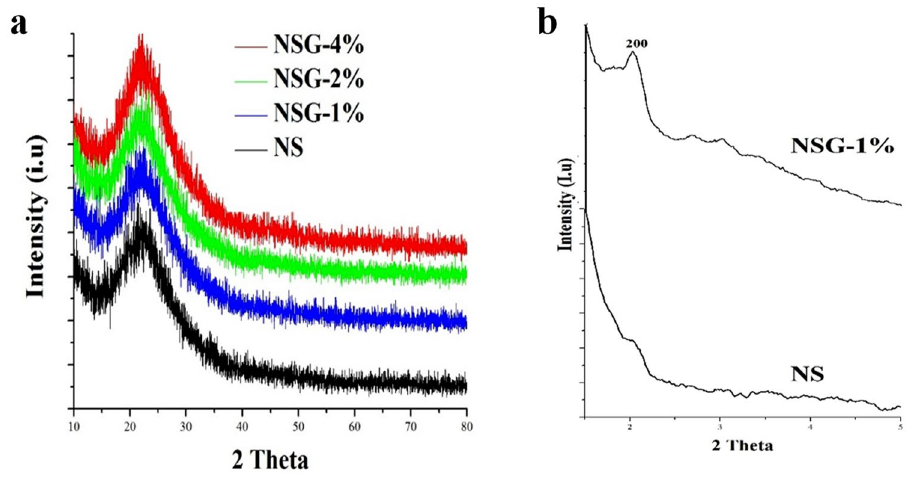
Figure 6. XRD analysis of mesoporous silica in wide ( a ) and low diffraction (b )